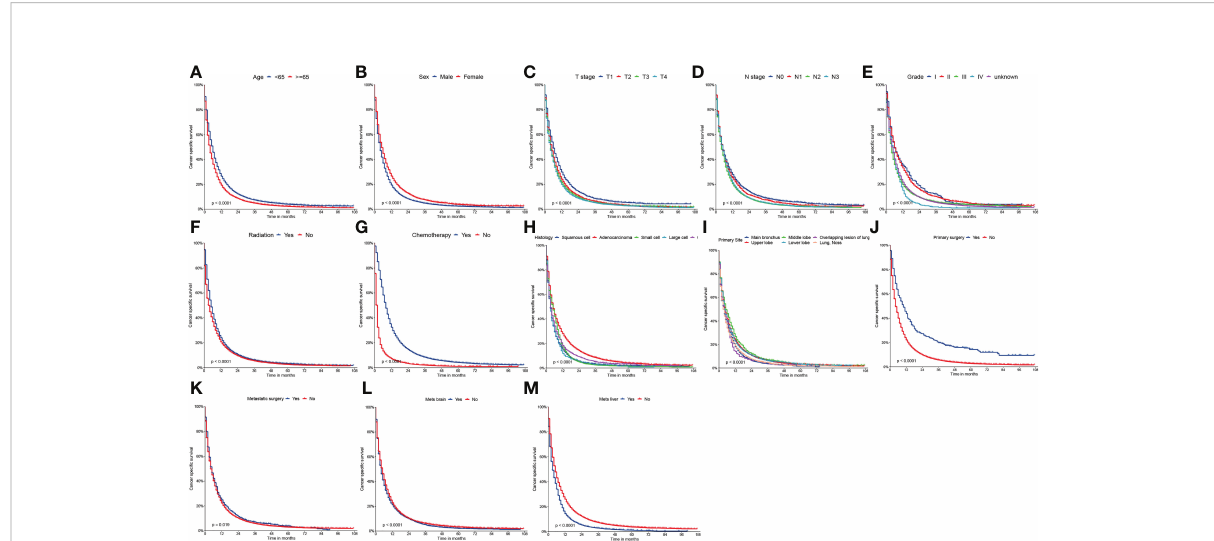
FIGURE 3 Kaplan-Meier curves of CSS (A) age, (B) sex, (C) T stage, (D) N stage, (E) grade, (F) radiation, (G) chemotherapy, (H) histology, (I) primary site, (J) primary surgery, (K) metastatic surgery, (L) mets-brain and (M)